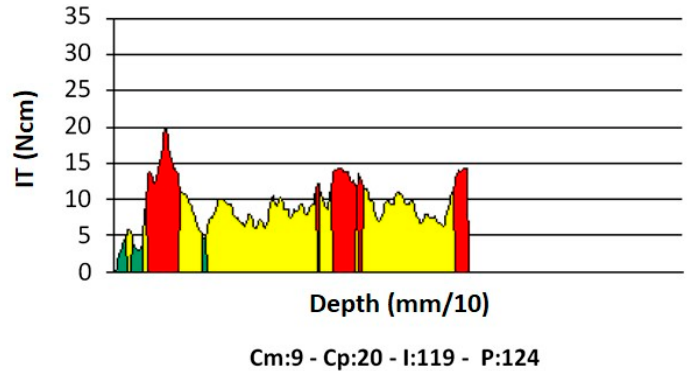
Figure 3. An example of a torque–depth plot generated from the micromotor measurements of bone density and during implant insertion. Cm, average torque; Cp, peak torque; I, integral of the torque– depth curve; P, depth reached by the probe/implant in tenths of a